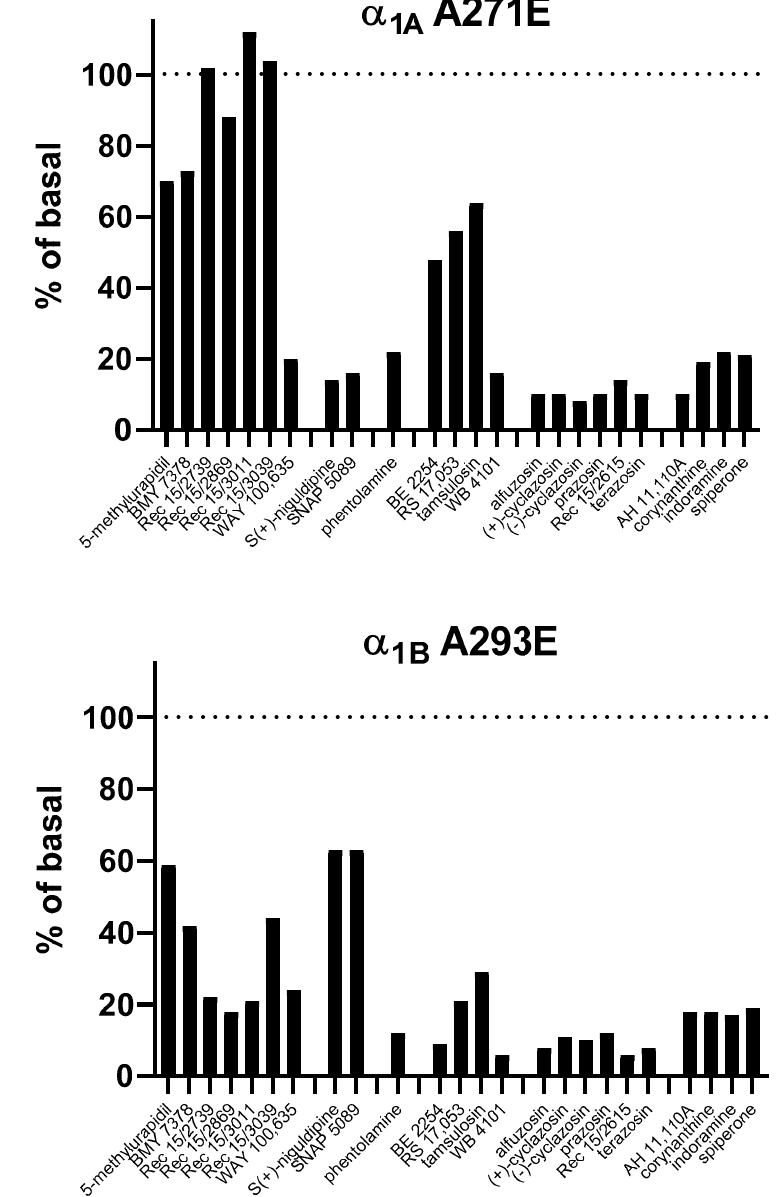
Figure 3. Inhibition of basal inositol phosphate formation in cells stably transfected with CAM of α 1A -adrenoceptors (AR) (A271E mutation) and α 1B -AR (A293E mutation). The figure was modified with permission from [19]. All compounds were tested at a concentration of 10 µM, except for Rec 15/3039 (100 µM), and data are shown as means of three–six experiments. Compounds are grouped based on structural similarities as classified by the original authors from left to right as N -arylpiperazines, 1,4- dihydropyridines, imidazolines, benzodioxans and phenylalkylamines, quinazolines, and ‘other’.